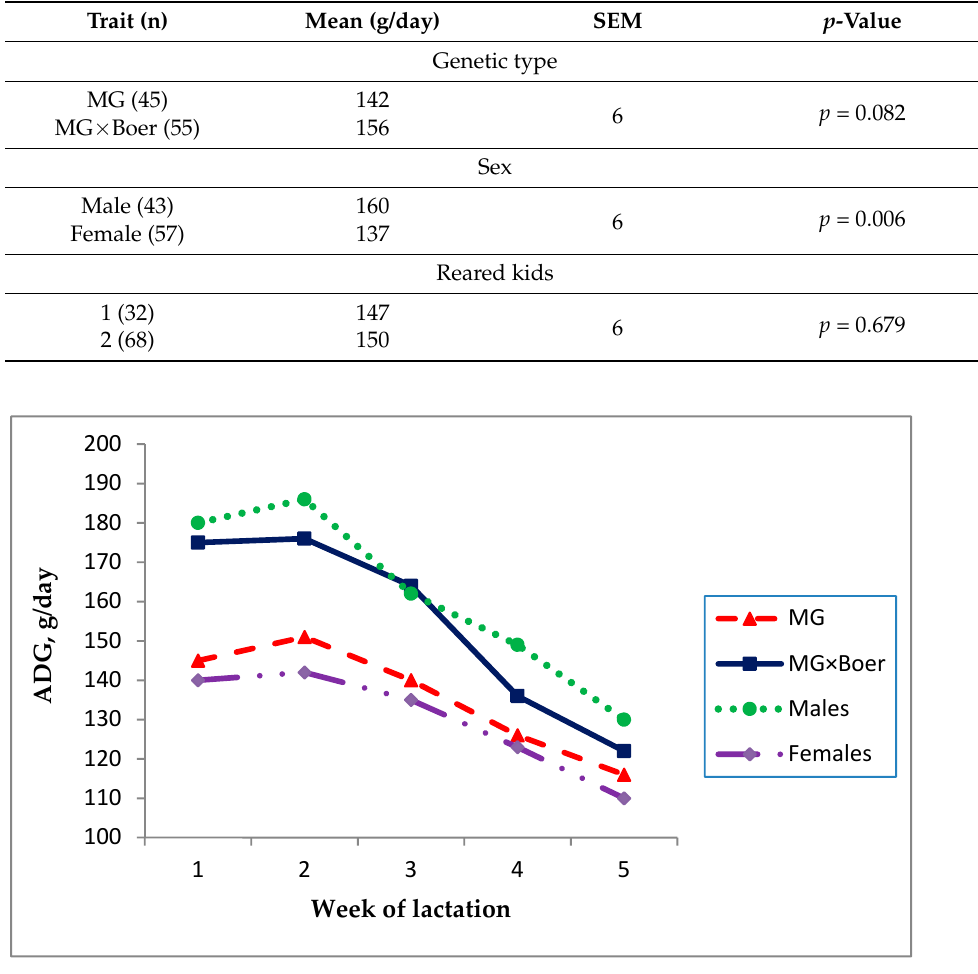
Figure 2. Evolution of the average daily gain (ADG) associated with the effects of genetic type and sex of the kids, in a mixed rearing system (MG = Murciano-Granadina).